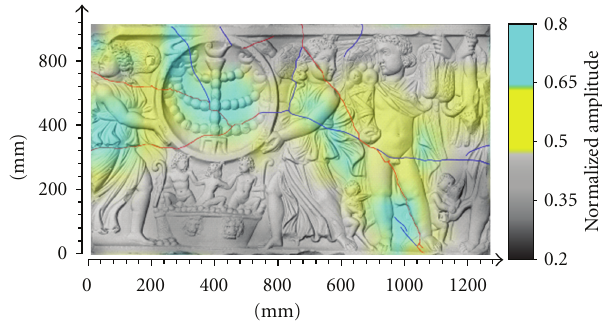
Figure 6: Smoothed 2D tomographic section, using 2 × 2cm 2 cell dimension, superimposed to slab image.